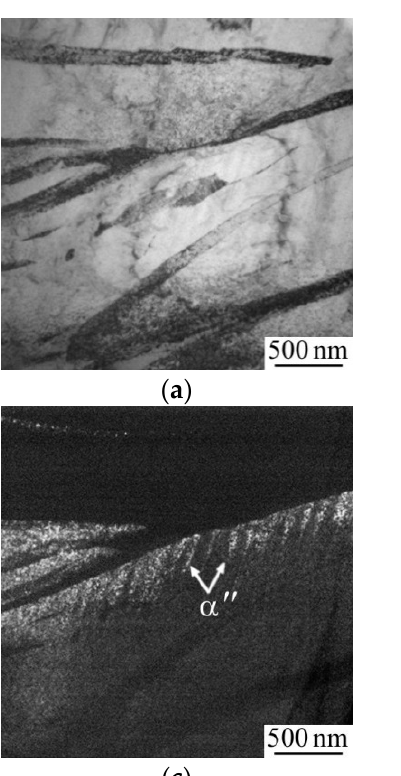
Figure 9. Bright- ( a ) and dark-field TEM micrographs ( b , c ), and the associated SAED pattern with indexing scheme ( d ) of the microstructures of the EBAM Ti-6Al-4V samples produced with substrate cooling. The dark-field TEM micrographs were obtained with the 111(cid:3435)132(cid:3439) α -Ti and 110(cid:4666)111(cid:4667) β -Ti (b), 0 21(cid:3435)312(cid:3439) α ʹʹ -Ti and 111(cid:3435)112(cid:3439) α -Ti reflections ( c ). The microstructure was obtained at a distance of 40 mm from the substrate.